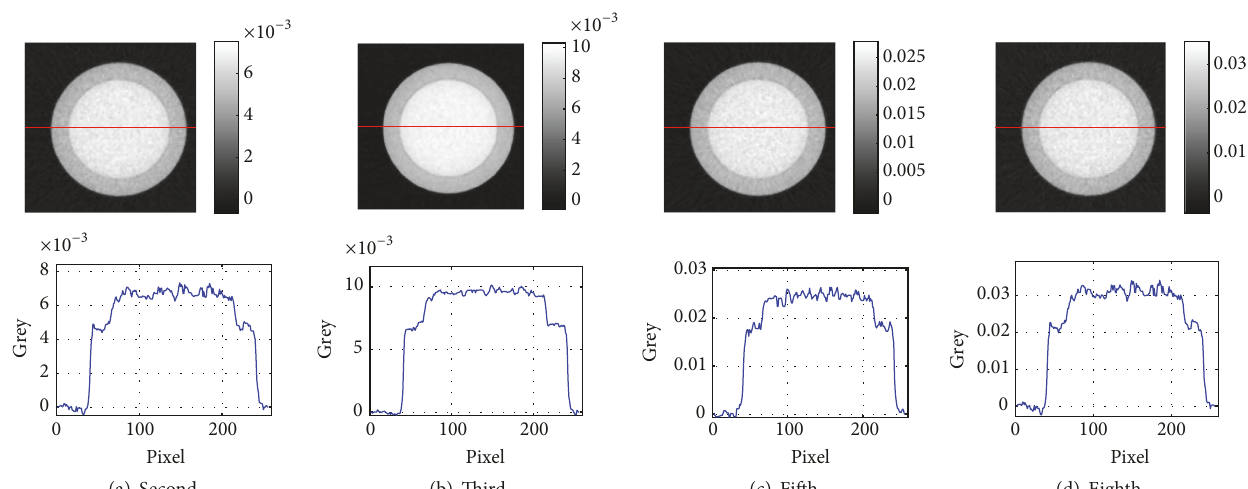
Figure 3: Four representational reconstructed images obtained by the method of